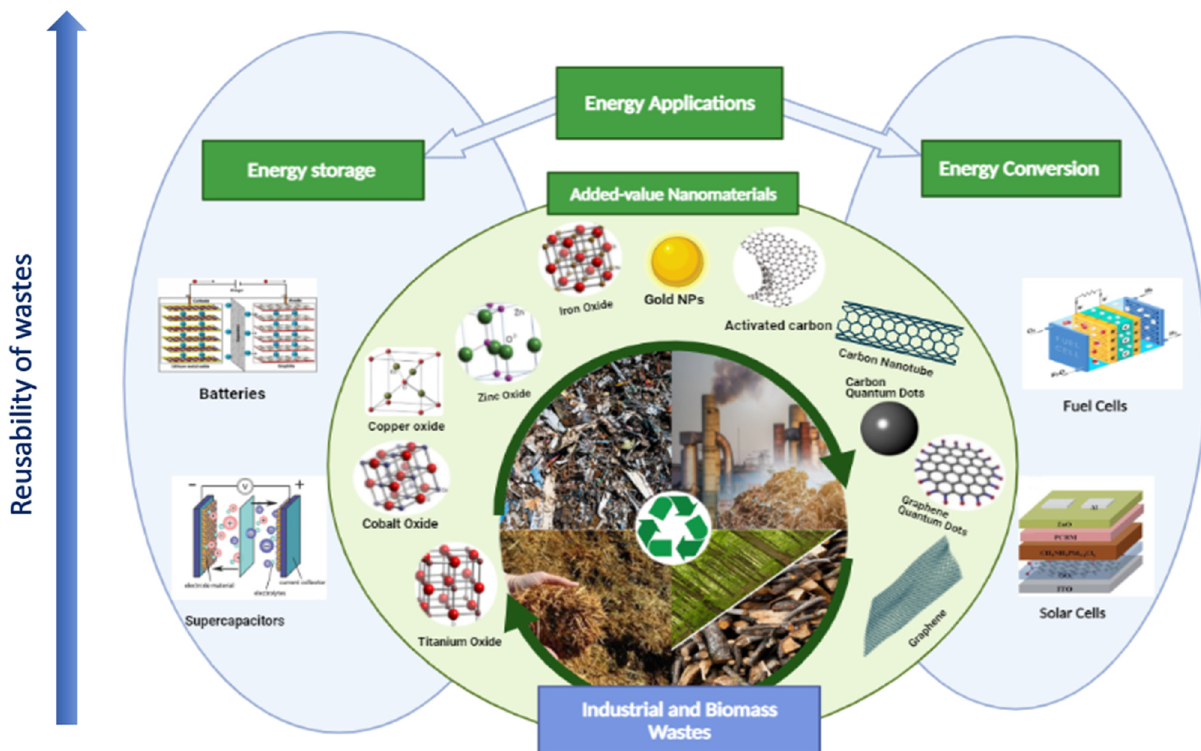
Figure 3: Schematic of recycled NMs from biomass and industrial wastes and their energy